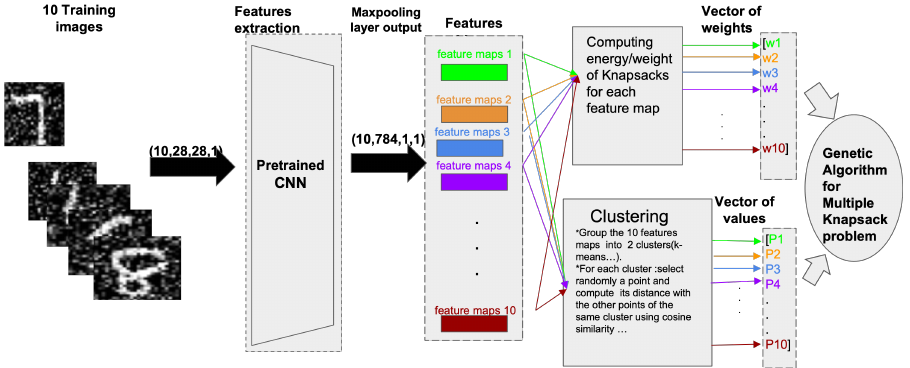
Figure 4. Illustration of the relationship between the genetic algorithm and the CNN at the train- ing phase.